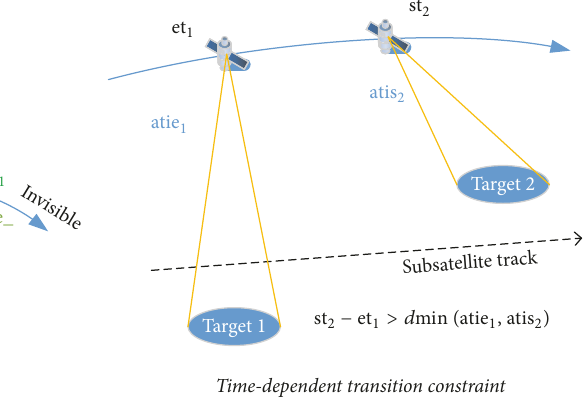
Figure 1: Temporal constraint of agile